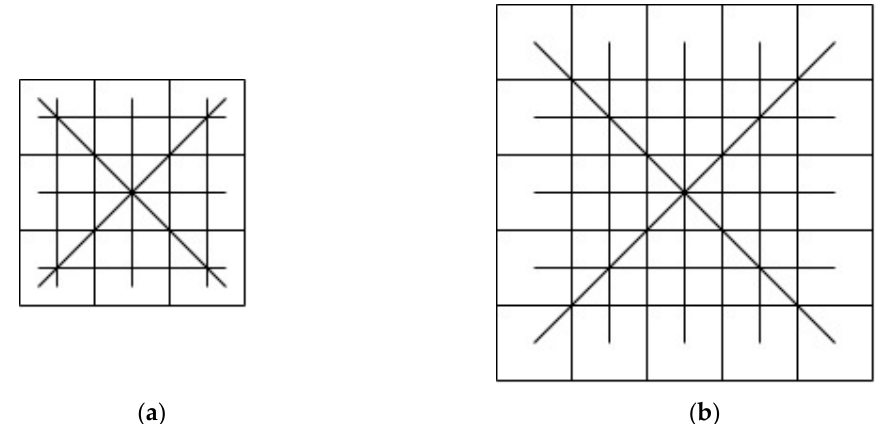
Figure 1. ( a ) (3,2)-hypercube with its winning lines and ( b ) (5,2)-hypercube with the (3,2)-hypercube extended winning lines.